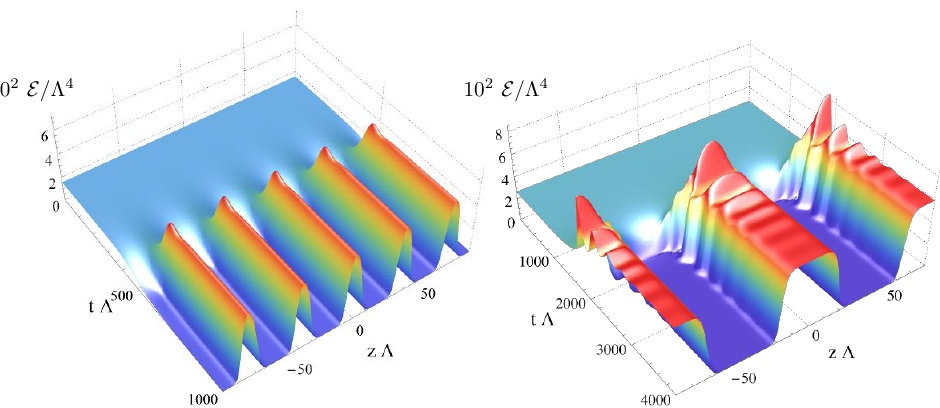
Figure 16 . (Left) Energy density of the evolution of an initial state with E ( t = 0) = E 3 ; L (cid:3) ’ 187 and initial mode n = 5. (Right) Energy density of the evolution of an initial state with E ( t = 0) = E 1 ; L (cid:3) ’ 160 and initial mode n =